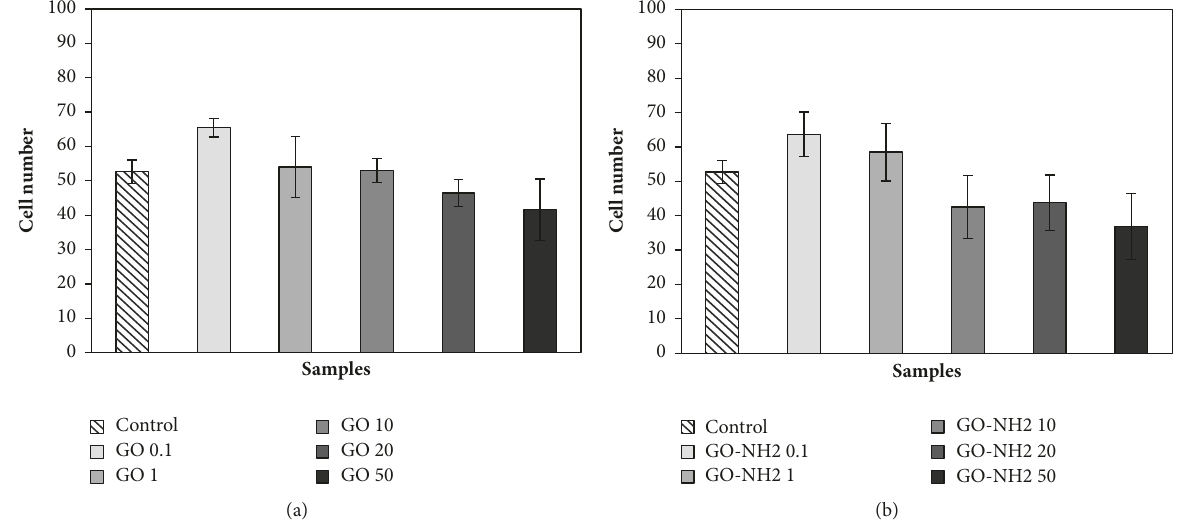
Figure 6: Number of viable A549 cells after 24 hours incubation in the presence of ( 1 ) GO and (b) GO-NH 2